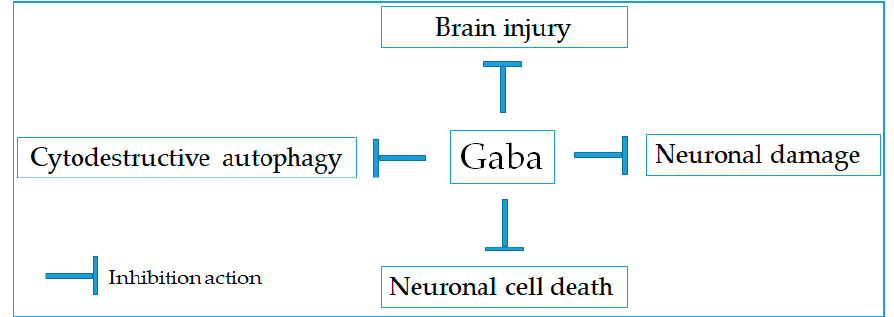
Figure 1. Therapeutic targets for neuroprotective activity of Gaba. Table 1. Neuroprotective effect of Gaba.